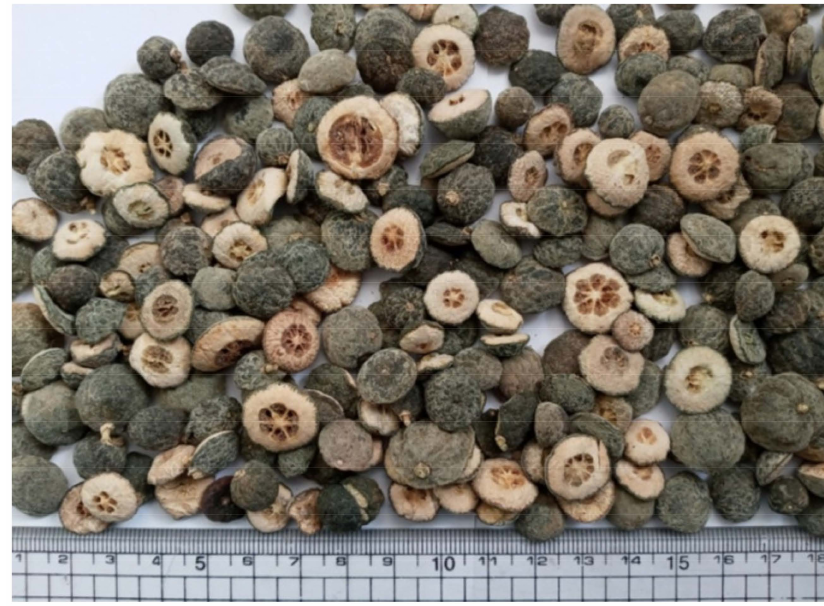
Figure 10. Photograph of Ponciri Fructus (dried immature fruits of P. trifoliata